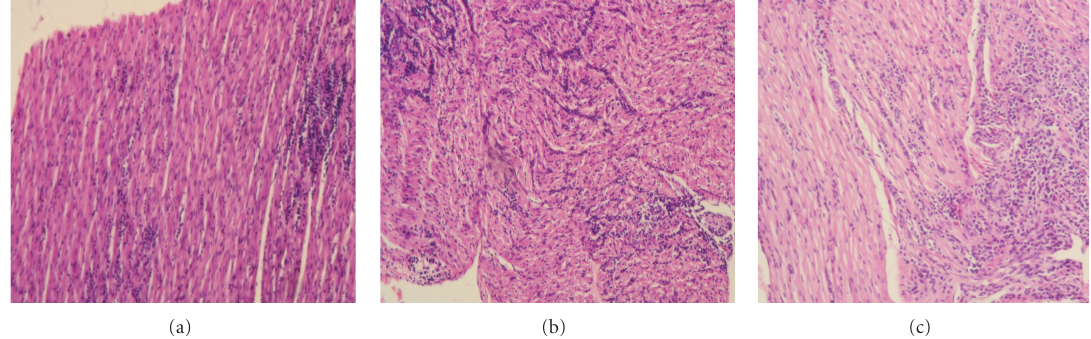
Figure 5: (a) Slight myocarditis in ventricular wall of dog 9 of the low dose group. (b) Lymphoplasmacytic myocarditis in ventricular wall of dog 2 of the high dose group. (c) Ventricular wall of dog 4 of medium dose group. Even a dose as low as 2000 trypomastigotes per kilogram of T. cruzi strain Sylvio 10x can produce evident lesions in myocardium of